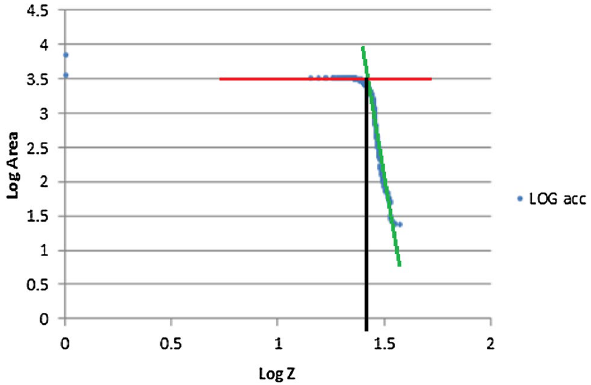
Fig. 9 Determining the threshold